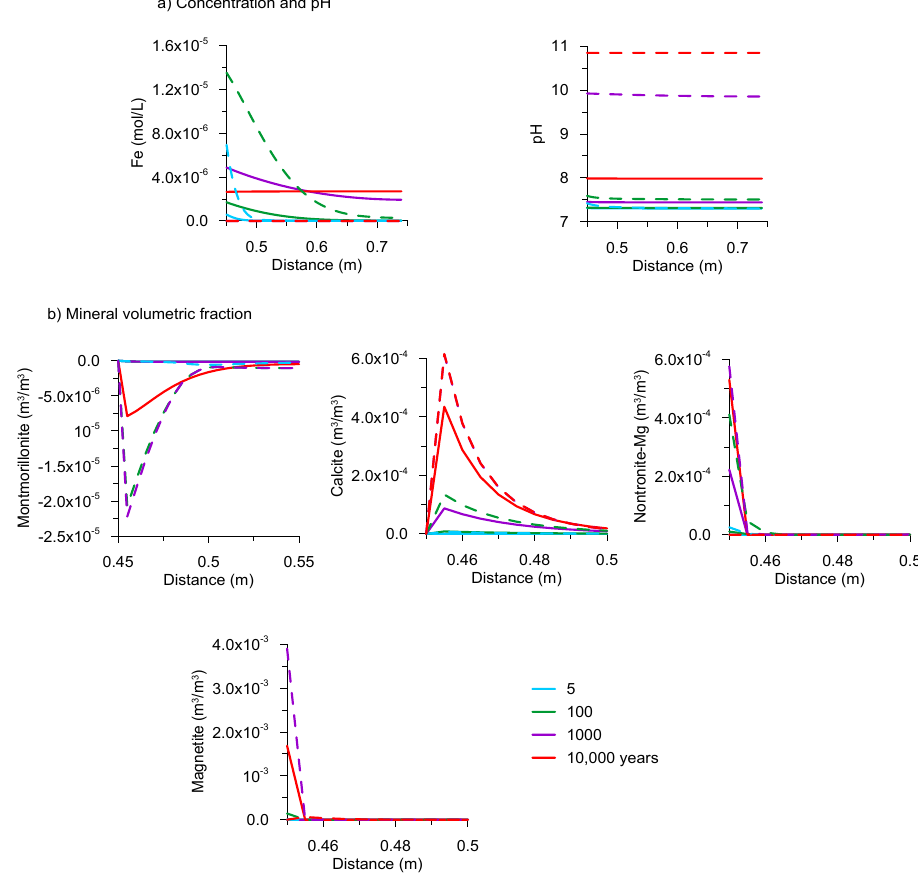
Figure 6. Results of the numerical model with a corrosion rate of 0.1 µ m y − 1 (continuous lines) are compared with those from the reference model (r = 2 µ m y − 1 , dashed lines). The interface between steel and bentonite is at 0.45 m. Results at 5, 100, 1000 and 10,000 years of interaction are compared. ( a ) Fe concentration and pH against distance. ( b ) Volumetric fraction of minerals versus distance. For the primary phases (montmorillonite and calcite) a variation of the volumetric fraction is plotted. Positive values mean precipitation and negative values mean dissolution. The reference model results for montmorillonite at 10,000 are not plotted (see Figure 3 for that